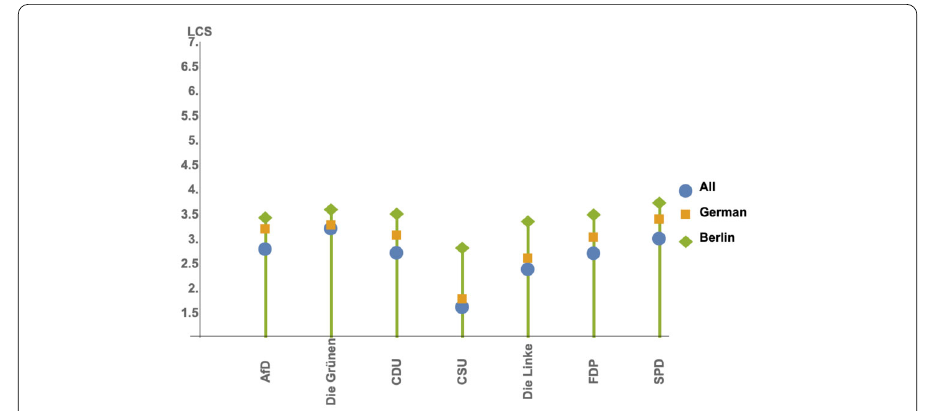
Figure 9 Mean of LCS for all 3 datasets for parties. Shown are the values for the mean Length of LCS for all result lists, German result lists and the result lists for Berlin,